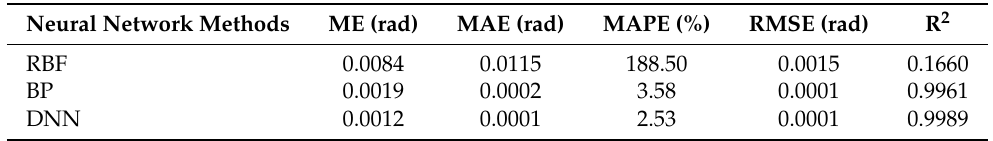
Table 2. The accuracy of different neural network methods (yaw